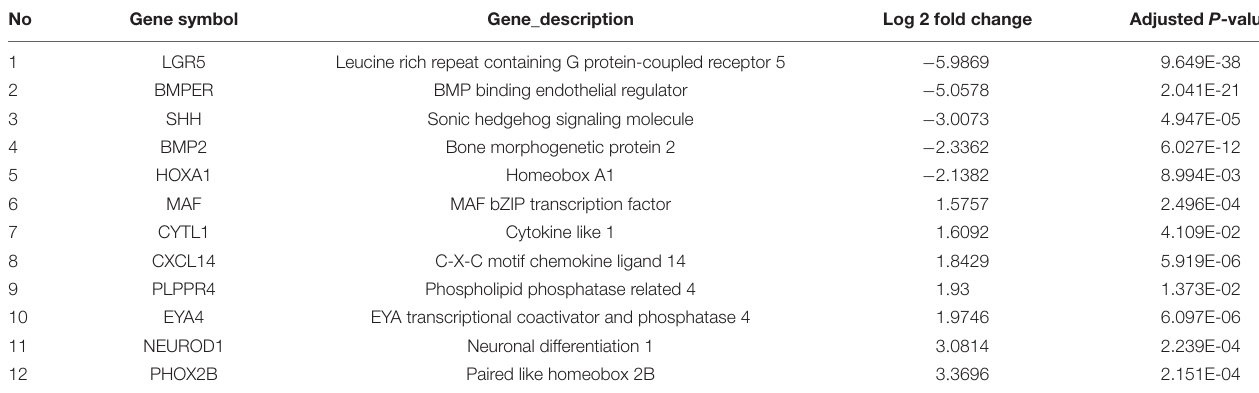
TABLE 3 | Differentially expressed genes in patient iNCCs enriched in inner ear